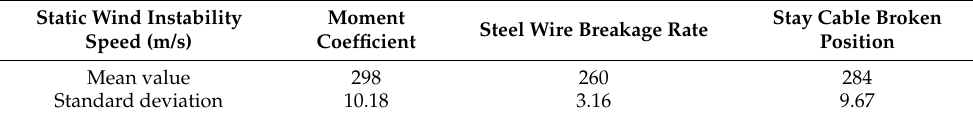
Table 7. Statistic characteristic values of wind speed for static wind instability.